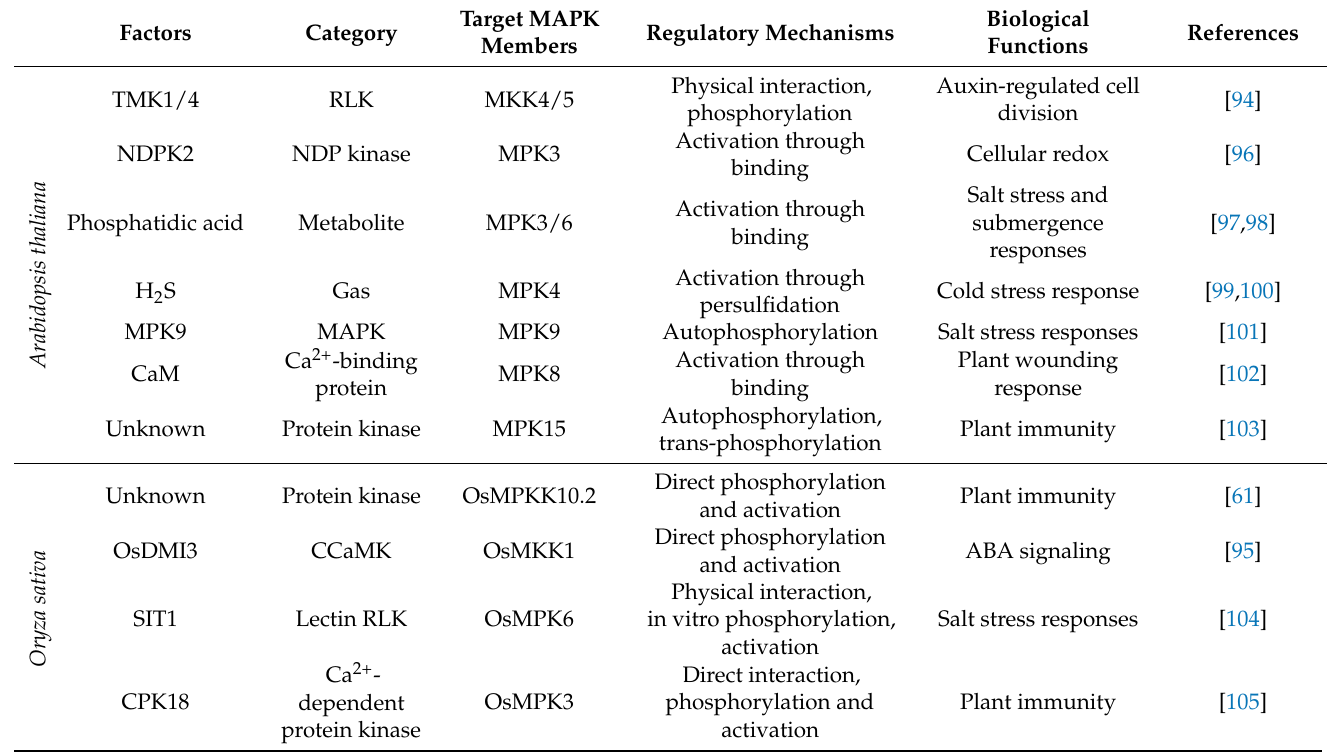
Table 3. Uncanonical activation of MAPK members in